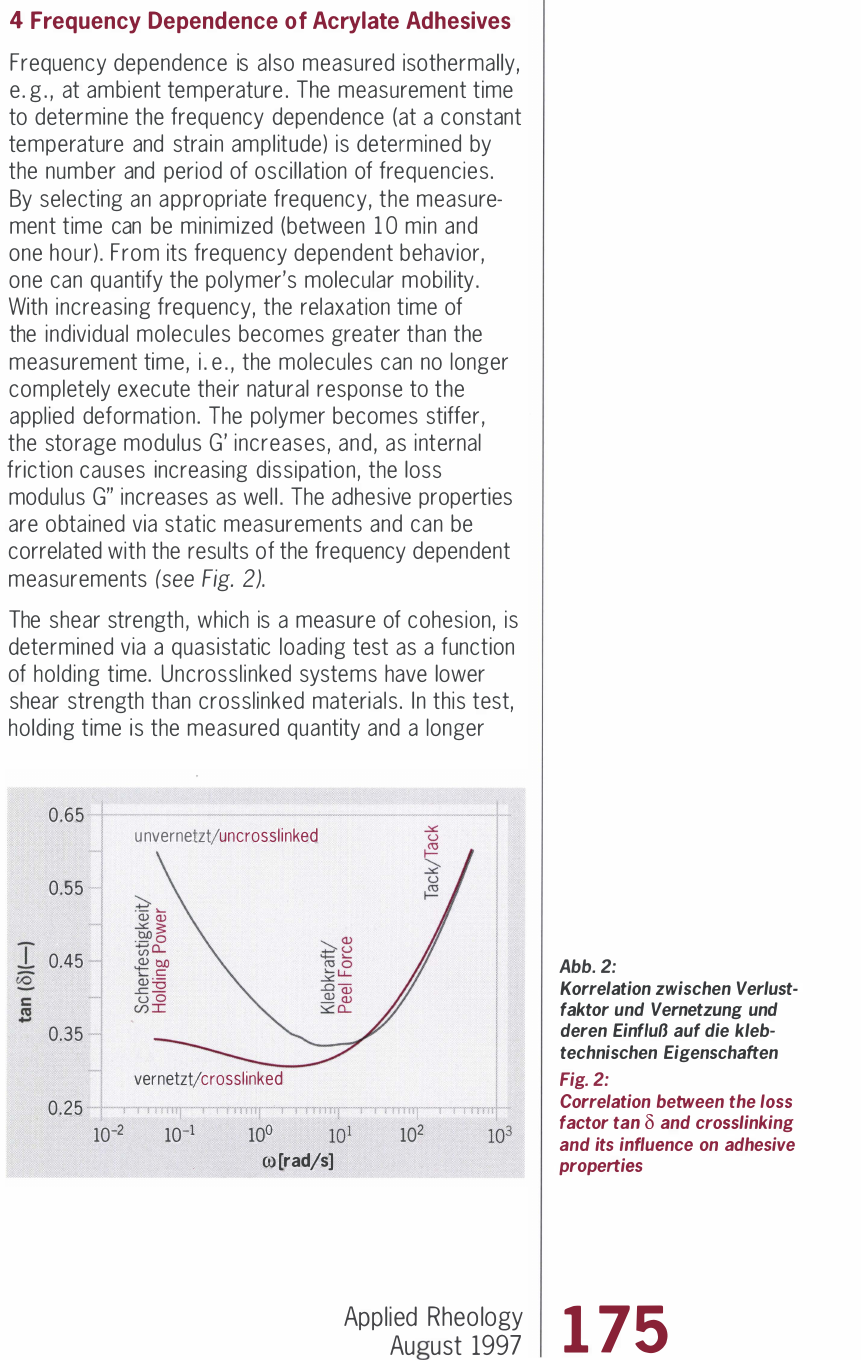
Fig. 2: Correlation between the loss factor tan o and cross/inking and its influence on adhesive